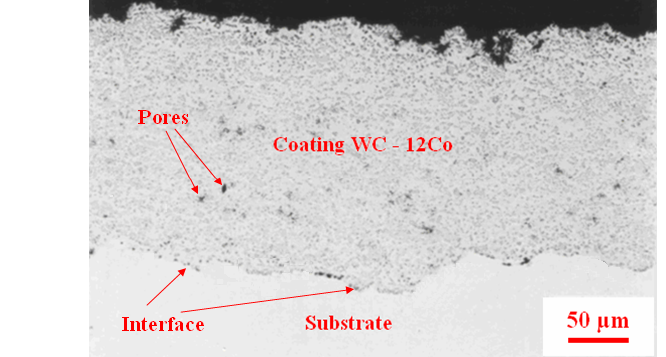
Figure 7 – Microstructure of the WC – 12wt.%Co coating deposited with a helium feed rate of 32